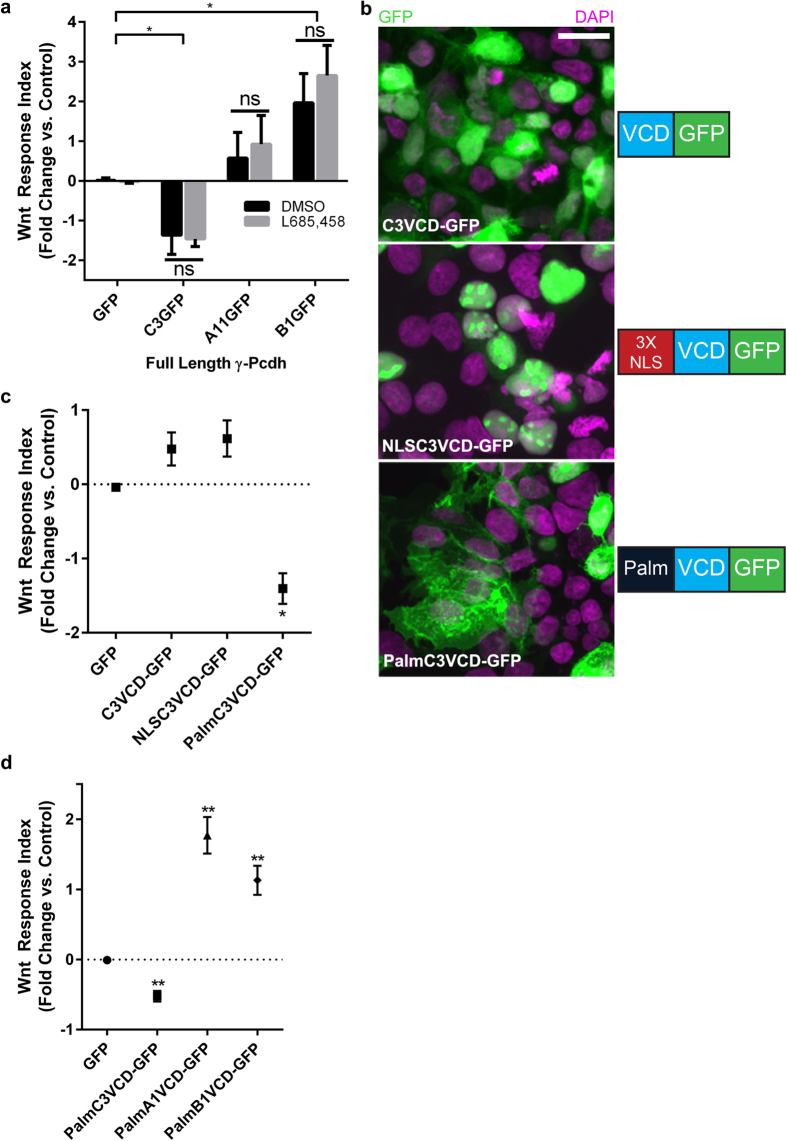
The γ-Pcdh-C3 VCD acts at the membrane to inhibit Wnt signalling.(a) Cells transfected with FL-C3GFP, FL-A11GFP and FL-B1GFP were treated with 10 μM L685,458 (to inhibit γ-secretase), or DMSO (vehicle control) and used in a TOPFlash assay, as previously described. Treatment with L685,458 did not significantly alter individual γ-Pcdh isoforms’ effect on Wnt signalling activity, indicating that C-terminal cleavage is not required. (b) Constructs encoding the isolated VCD of γ-Pcdh-C3 fused to GFP, either unmodified (C3VCD-GFP), tagged with a triplicate nuclear localization signal (NLSC3VCD-GFP) or with a palmitoylation sequence (PalmC3VCD-GFP) were generated. HEK293 cells transfected with these constructs were immunostained for GFP (green) and counterstained with DAPI (purple) to assess subcellular localization and visualize nuclei, respectively. Localization was as predicted: C3VCD-GFP localizes to both cytoplasm and nucleus, NLSC3VCD-GFP is restricted to nuclei, and PalmC3VCD-GFP is concentrated at the cell surface and at cell-cell junctions. Scale bar = 20 μm. (c) These new constructs were used in a TOPFlash assay, as described previously. PalmC3VCD-GFP was the only construct that significantly inhibited Wnt signalling activity; C3VCD-GFP and NLSC3VCD-GFP did not differ significantly from control. (d) Palmitoylated A1VCD-GFP and B1VCD-GFP were made and used in a TOPFlash assay. The VCD alone of these individual γ-Pcdh isoforms are sufficient to significantly upregulate Wnt signalling activity. Data are presented on a log2 scale of means ± SEM from 6 independent experiments. A two-way ANOVA with Bonferroni post hoc test (to correct for multiple comparisons) was performed to assess statistical significance. *p < 0.05 ** p < 0.01.